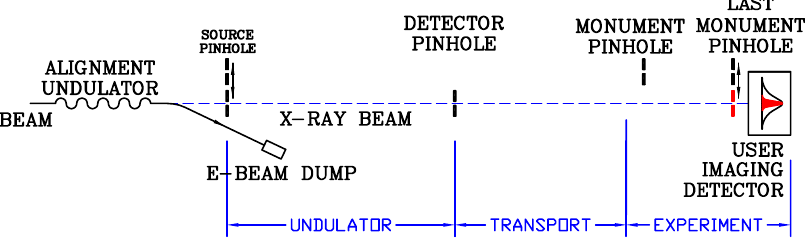
FIG. 9. (Color) Extension of XBA into transport and user experimental